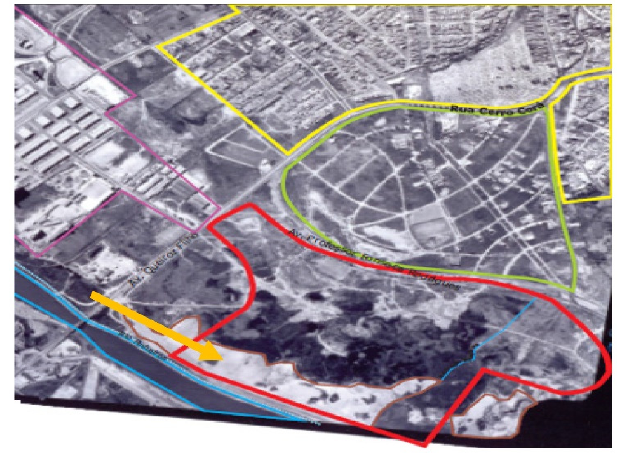
Figure 5. Villa-Lobos site. Earth movement in the south part of the area in 1968 [19].